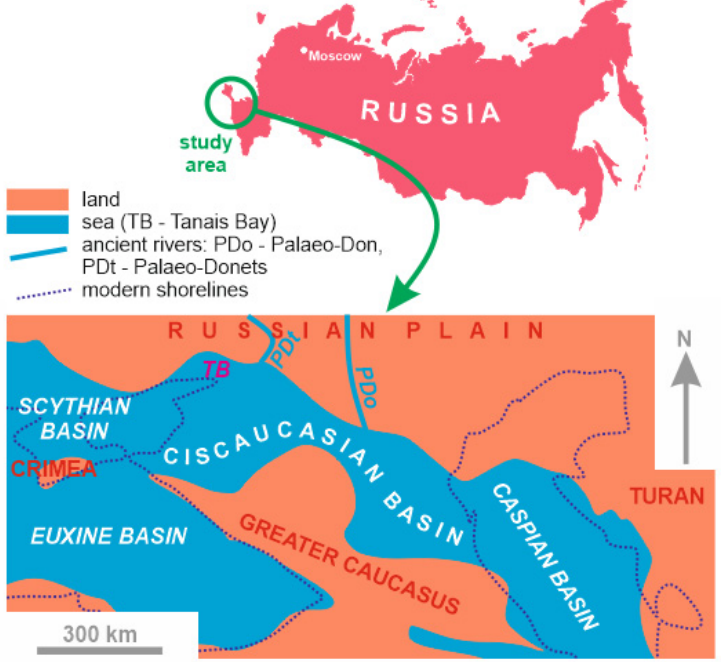
Figure 1. The Eastern Paratethys Sea in the Late Miocene (created by the author referring the palaeogeographical contours to [11]).